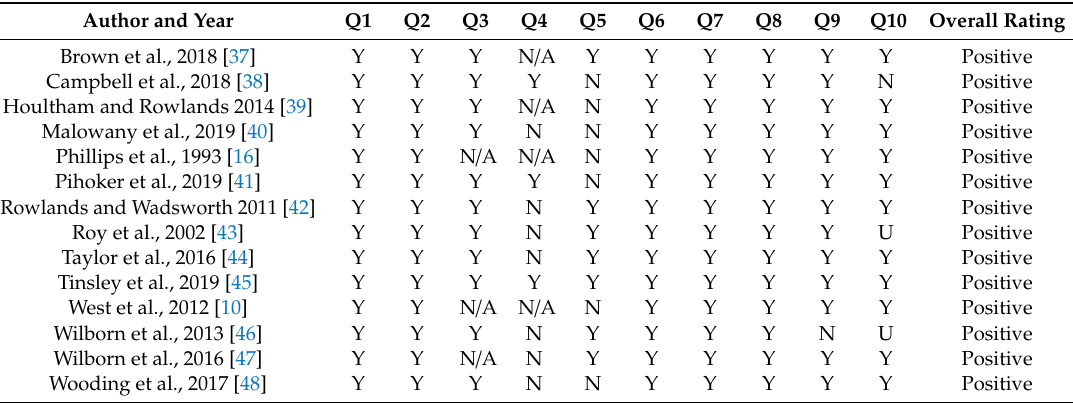
Table 1. Quality assessment of included